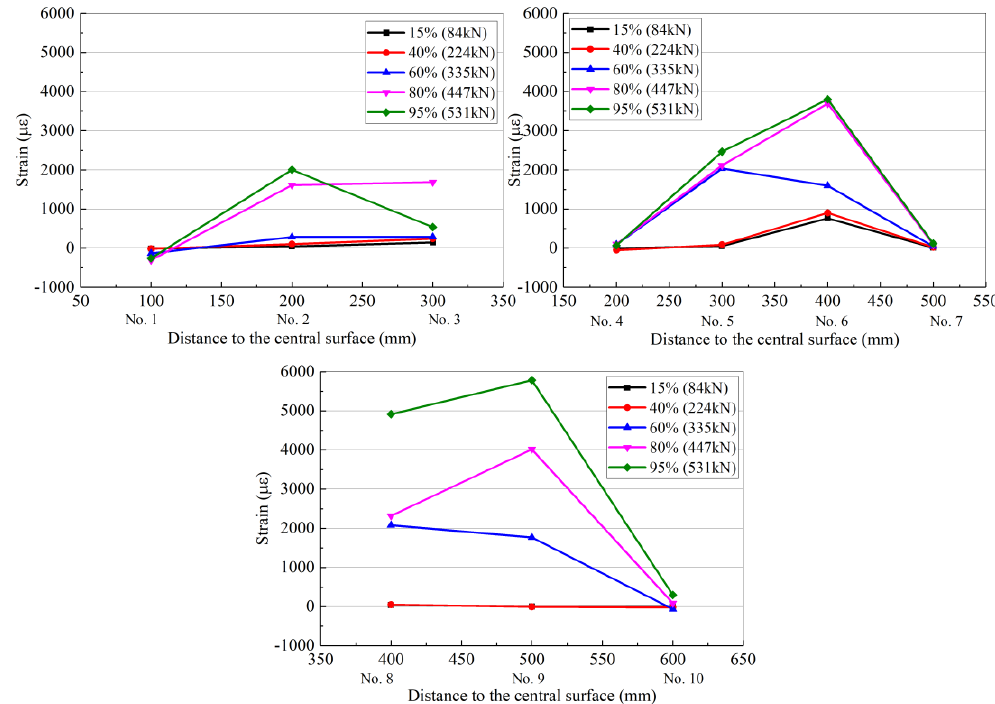
Figure 13. Strain distribution of flax fiber sheet for the RC-FRP3.